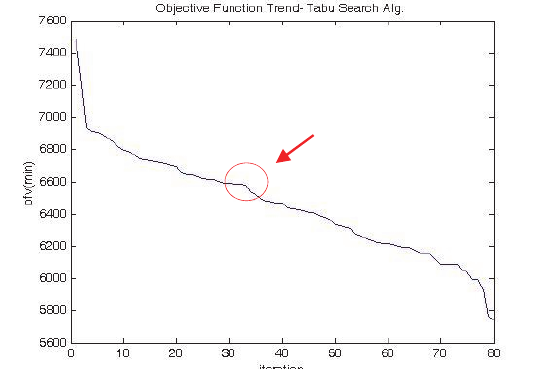
Fig. 7. Sample of escaping from local optimum traps by using local optimum escaping